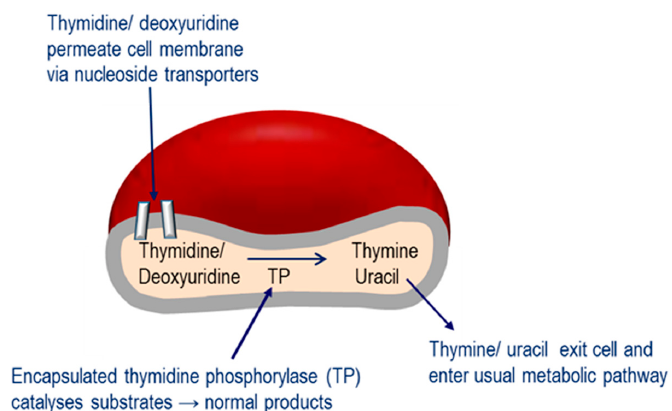
Figure 1. Mechanism of erythrocyte encapsulated thymidine phosphorylase (EE-TP) action. Plasma thymidine and deoxyuridine diffuse across the erythrocyte membrane via nucleoside transporters into the erythrocyte cytosol where the encapsulated thymidine phosphorylase (TP) catalyses their metabolism to thymine and uracil, which then exit the erythrocyte to enter the normal metabolic pathways. EE-TP has the advantage of prolonging the circulatory half-life of the enzyme to that of the erythrocyte half-life (19–29 days) and minimising immunogenic reactions, which are often observed in enzyme replacement therapies administered by the conventional